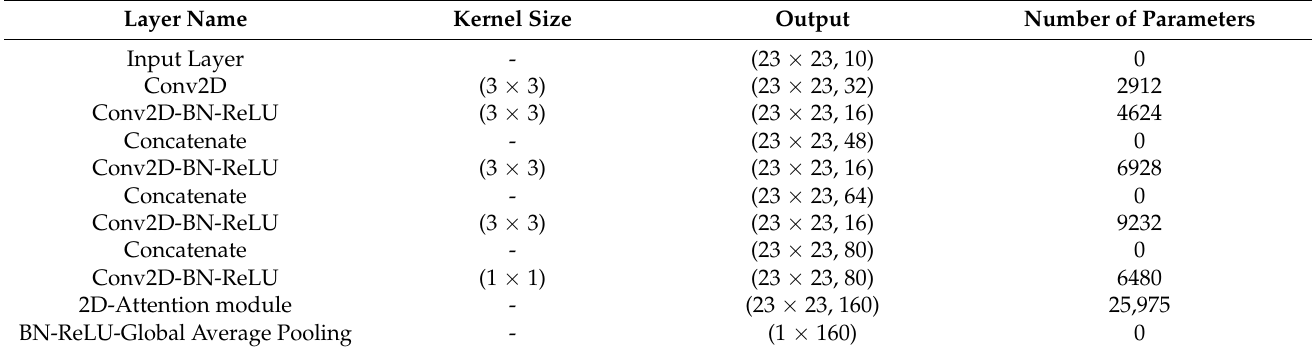
Table 6. Details of the 2D-DenseNet with dual